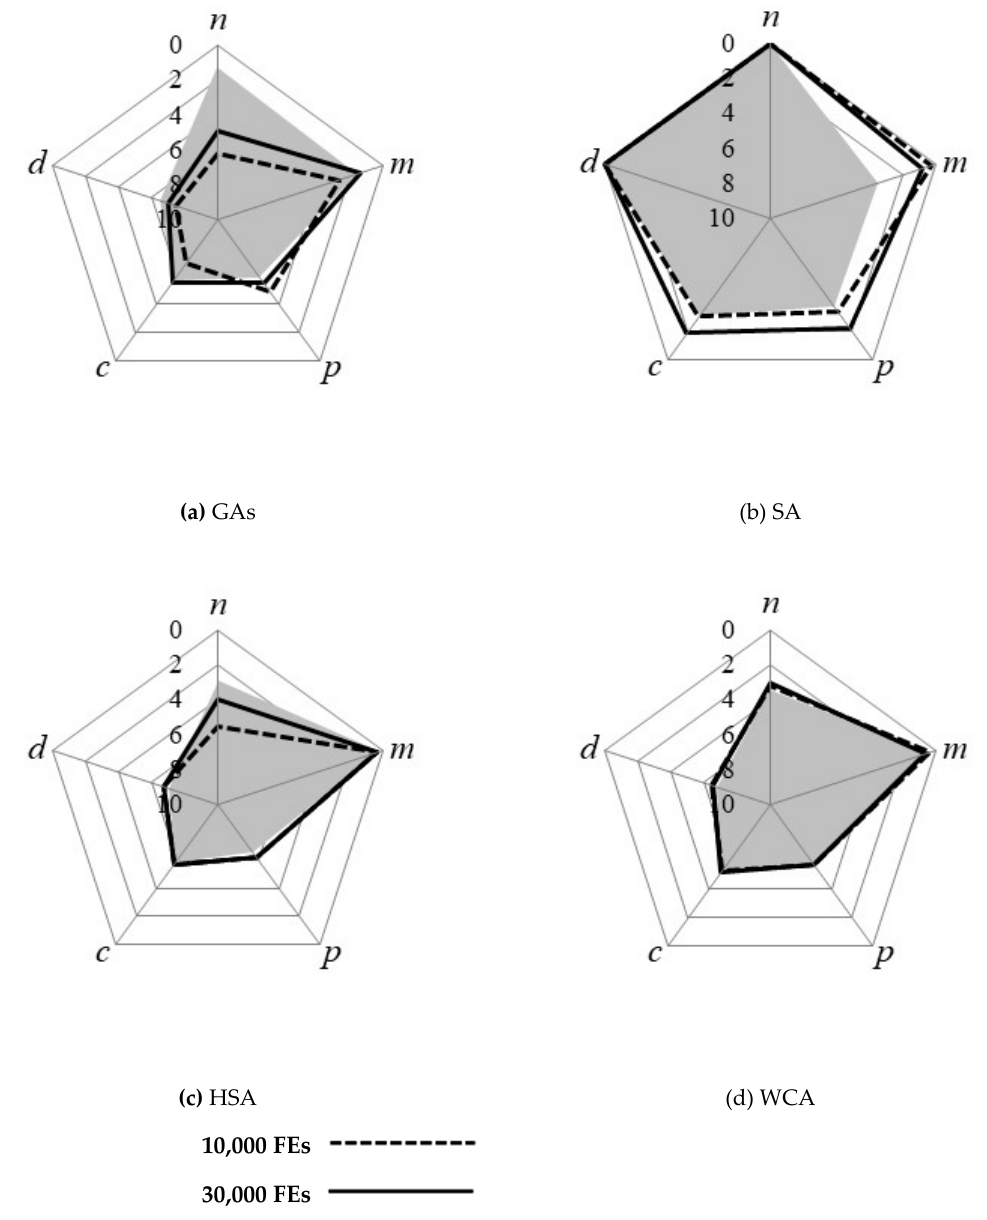
Figure 6. Performance comparison results (standard deviation of best improvement ratio). ( a ) GAs; ( b ) SA; ( c ) HSA; and ( d ) WCA.